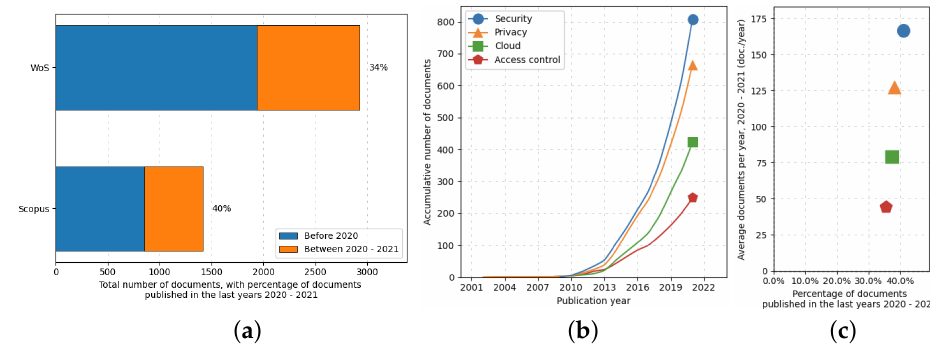
Figure 3. ScientoPy processing of the literature on privacy/security and access control in cloud applications: ( a ) percentage of works published since 2020 over all the relative literature, ( b ) number of published documents vs. publication years based on keywords, and ( c ) the average number of documents per year vs. percentage of published documents between 2020 and